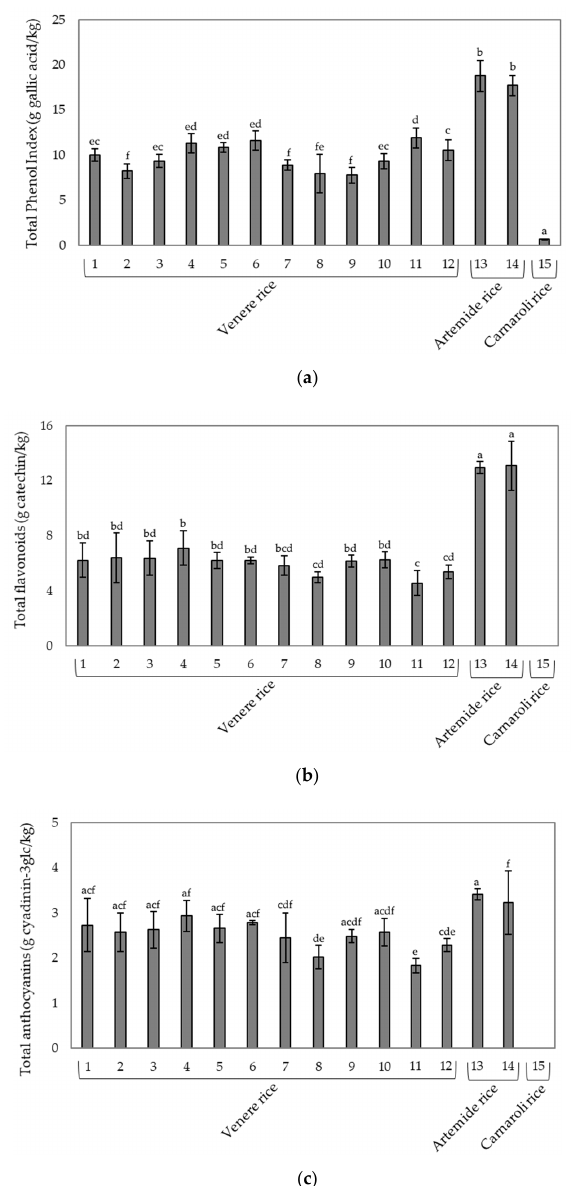
Figure 1. Phenolic compounds in raw rice cultivars. ( a ) Total phenol index (TPI); ( b ) total flavonoids; ( c ) total anthocyanins. Different letters mean significant differences ( p < 0.05).